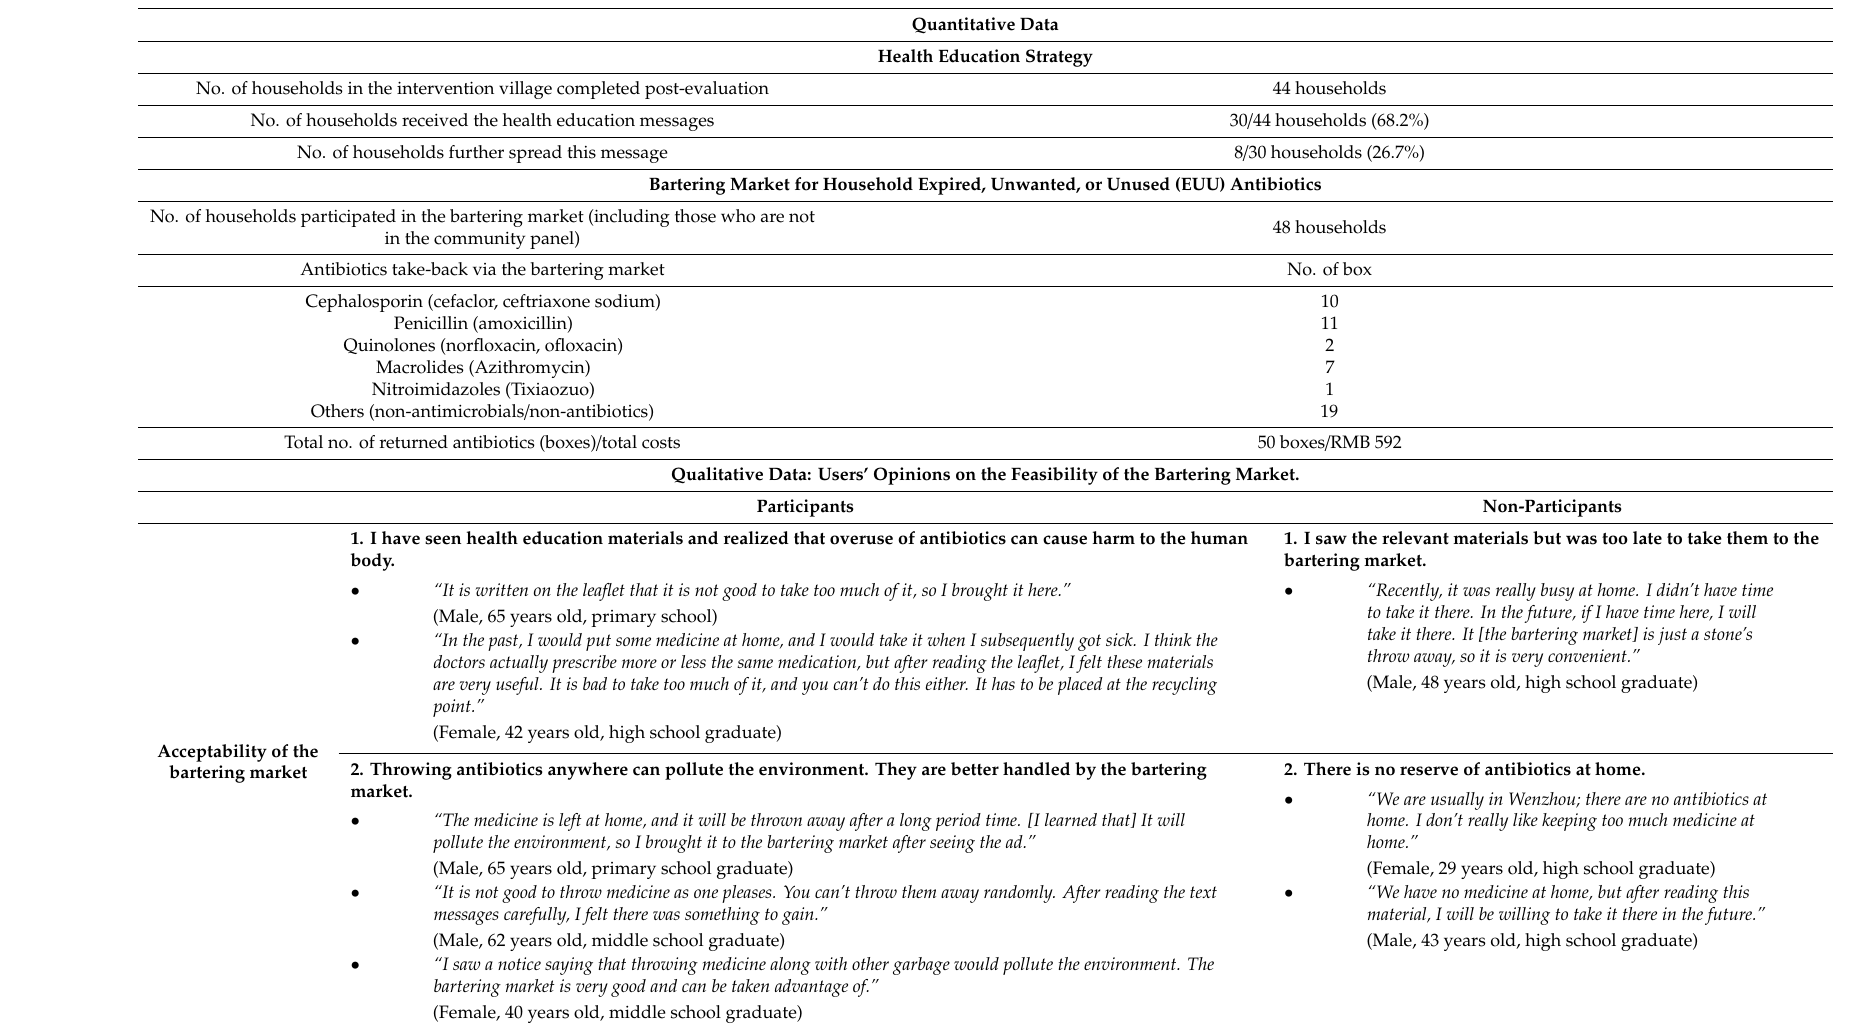
Table 3. Process evaluation on the antibiotic take-back